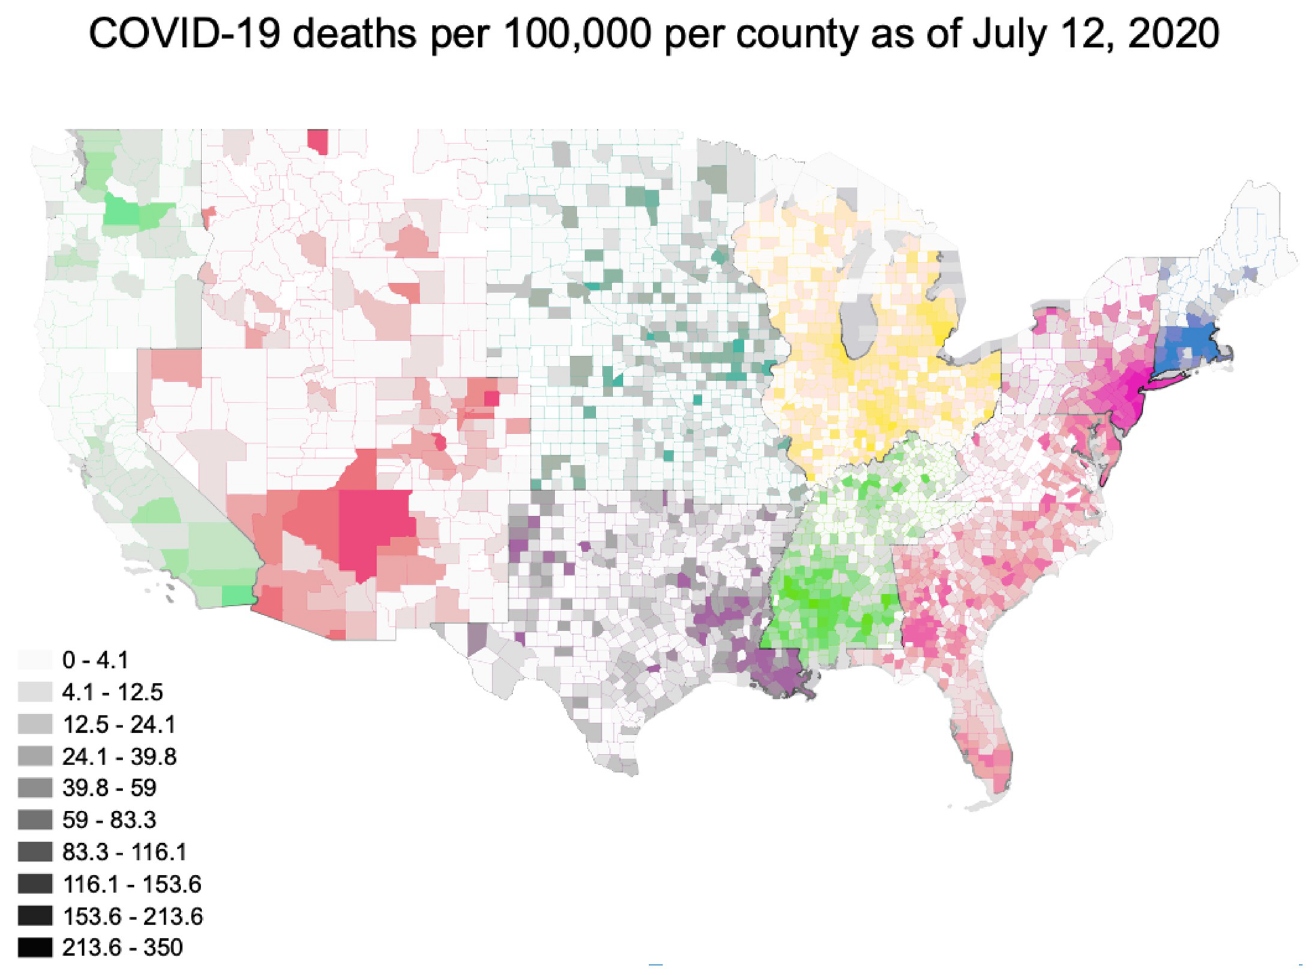
0.22 indirect, p < 0.001). The percentage of residents over 65, number of residents per square mile, and county population were all also significantly associated with more deaths. In urban counties (n = 115), the percentage of farmworkers and uninsured individuals were both significantly associated with more deaths, as was the percentage of residents over 65 and county population. Contrary to our initial hypotheses, in urban counties the percentage of uninsured individuals was associated with lower reported COVID-19 mortality. In these 115 counties, each percentage point decrease in the number of uninsured individuals was associ- ated with 73.8 fewer reported COVID-19 deaths (p = 0.03). In rural areas, each increase in the percentage of uninsured individuals was associated with a direct effect of 0.69 fewer deaths within the county (p < 0.001) and 0.19 fewer deaths in neighboring counties (p = 0.01). In non-urban counties (n = 2909), each percentage point increase in the number of farmworkers in a county was associated with 0.70 additional deaths (0.6 directly, 0.06 indirectly, p = 0.01). While neither the percentage of non-English speaking households nor the percentage of unin- sured residents was associated with a higher number of reported deaths, each percentage point increase in poverty was associated with 0.49 additional deaths (0.4 directly, 0.04 indirectly, p = 0.04).